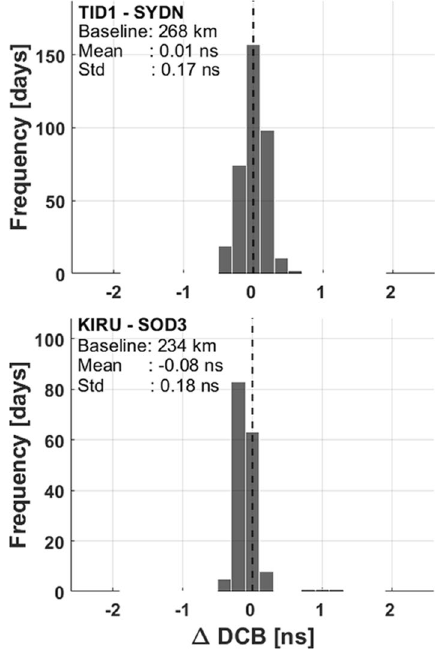
Fig. 5 Bias calculation error for longer baseline case. Top row shows results for low-latitude, middle one for mid-latitude and bottom one for high latitude stations’ pair. The black dotted line in the middle of each plot shows the zero DCB error